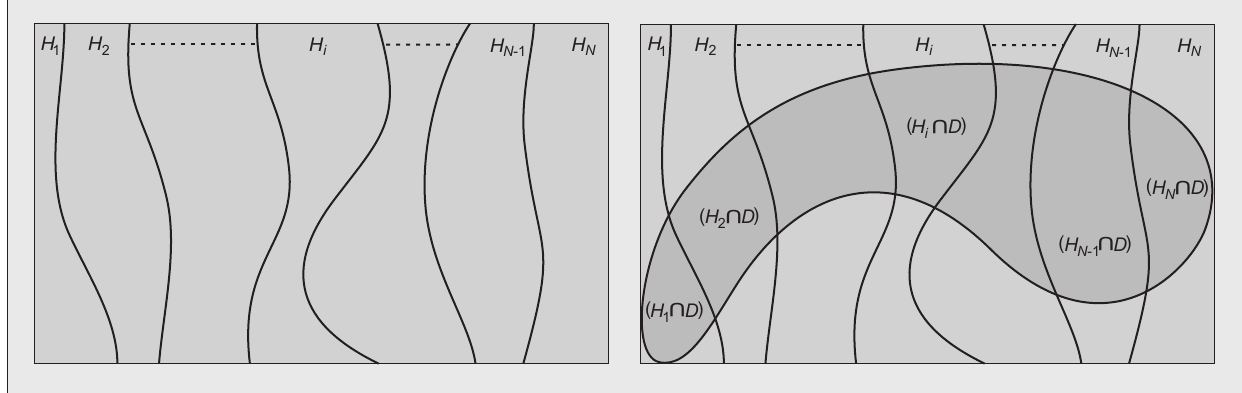
Figure 2. N mutually exclusive and exhaustive hypotheses { H hypothesis space